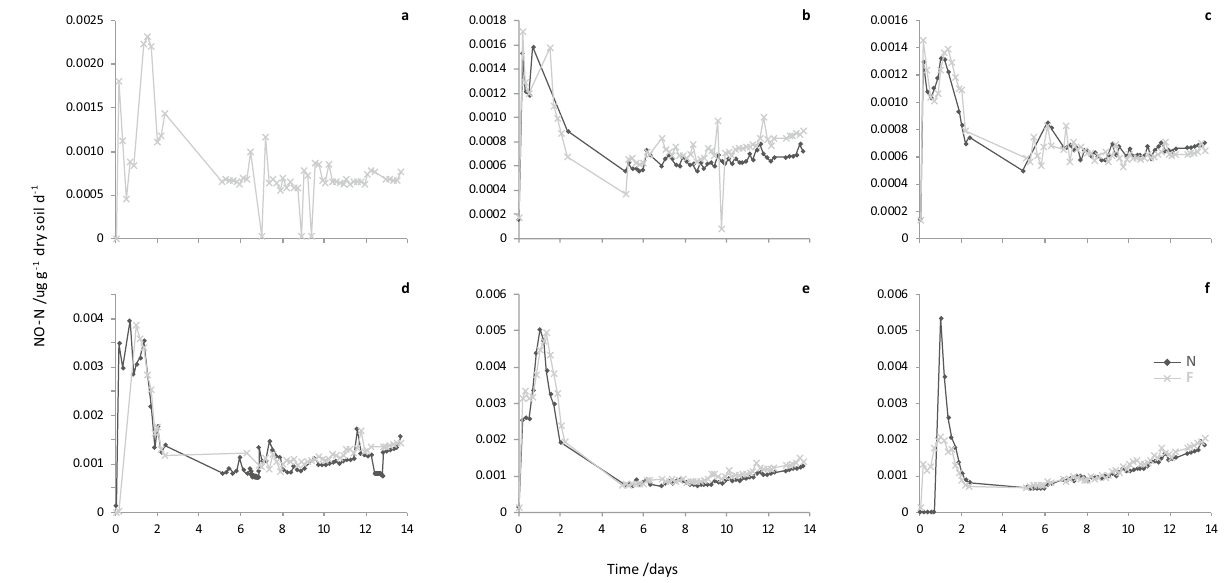
Figure 6. Graphs of paired NO-N fluxes (ug g −1 dry soil d −1 ) from soil amended with non-freeze-dried (N; dark grey diamonds) or freeze-dried and rehydrated (F; light grey crosses) sheep urine samples in FD-2: ( a ) LM1, ( b ) LM2, ( c ) LM3, ( d ) HM4, ( e ) HM5, ( f ) HM6. Gaps in data points (particularly between 2 and 6 days) result from instrument issues (i.e. no data was recorded during this time) in addition, a system error in the automated DENIS resulted in no data being recorded for LM1-N and only data for LM1-F is shown.